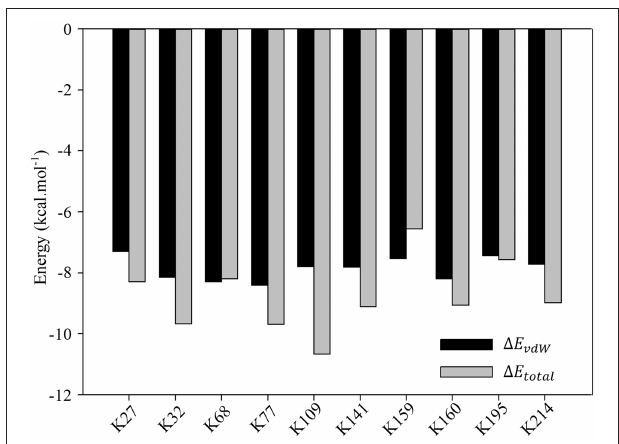
FIGURE 7 | Comparison of E vdW and E total for K27, K32, K68, K77, K109, K141, K160, K195, and